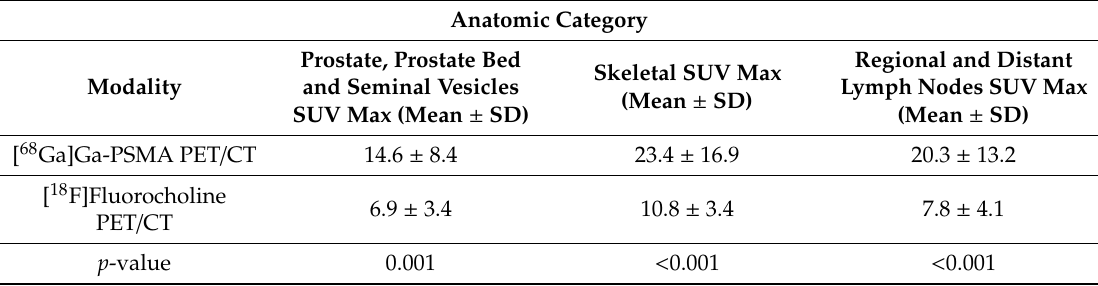
Table 2. Mean SUV max of concordant lesions in each anatomic category according to type of